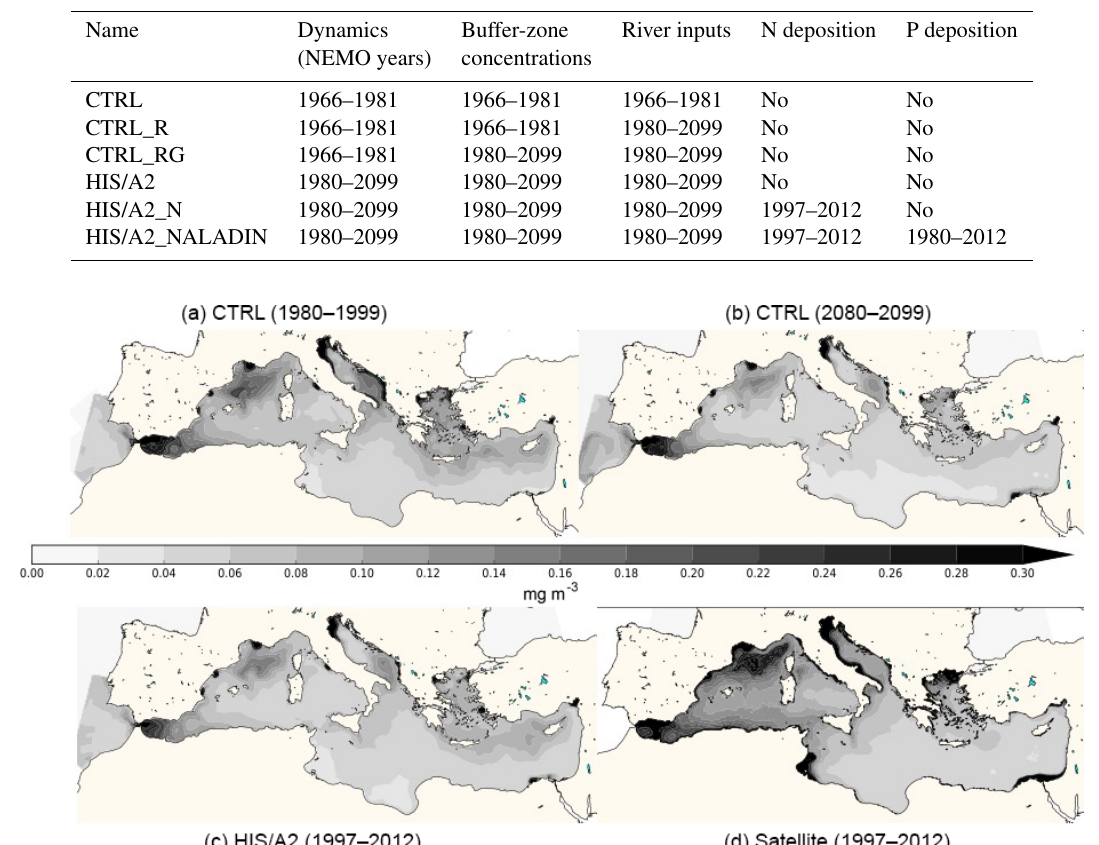
Figure 1. Average surface Chl a concentration from the CTRL ( a : 1980–1999, b : 2080–2099) and HIS/A2 (c) simulations and from satellite estimations (MyOcean dataset in 1997–2012: d